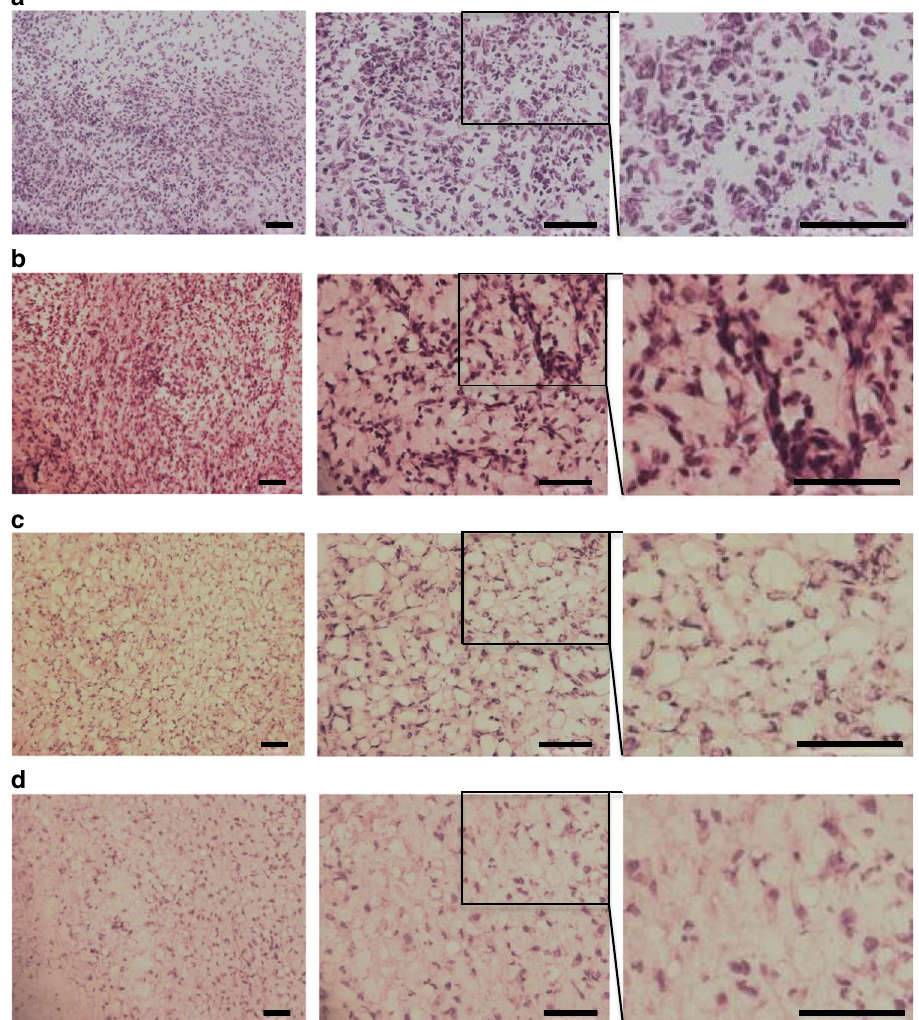
Fig. 6 Histological analysis of ankle joints. Fresh-frozen sections (10 µ m) of joints treated respectively with: a , BV CAR alone; b , HAdV5-PUMA alone (10 9 PFU); c , BV CAR HAdV5-PUMA (10 7 PFU); d , BV CAR HAdV5-PUMA (10 9 PFU); were stained with haematoxylin and eosin staining, and compared for the presence of synovial tissue in fi ltrates. The representative photograph from each group is provided at various magni fi cations (×200, left ; ×400, middle ; and ×800, right ). The righmost panels are enlargements of the rectangular area delineated in the middle panels. Scale bar, 200 µ